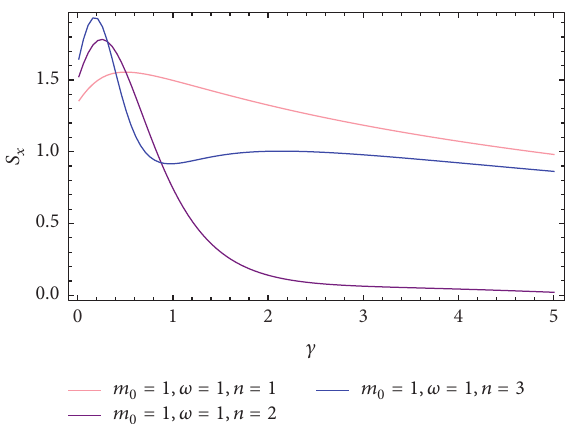
Figure 6: Position Shannon information entropies 𝑆 𝑥 versus 𝛾 . Figure 7: Position Shannon information entropy 𝑆